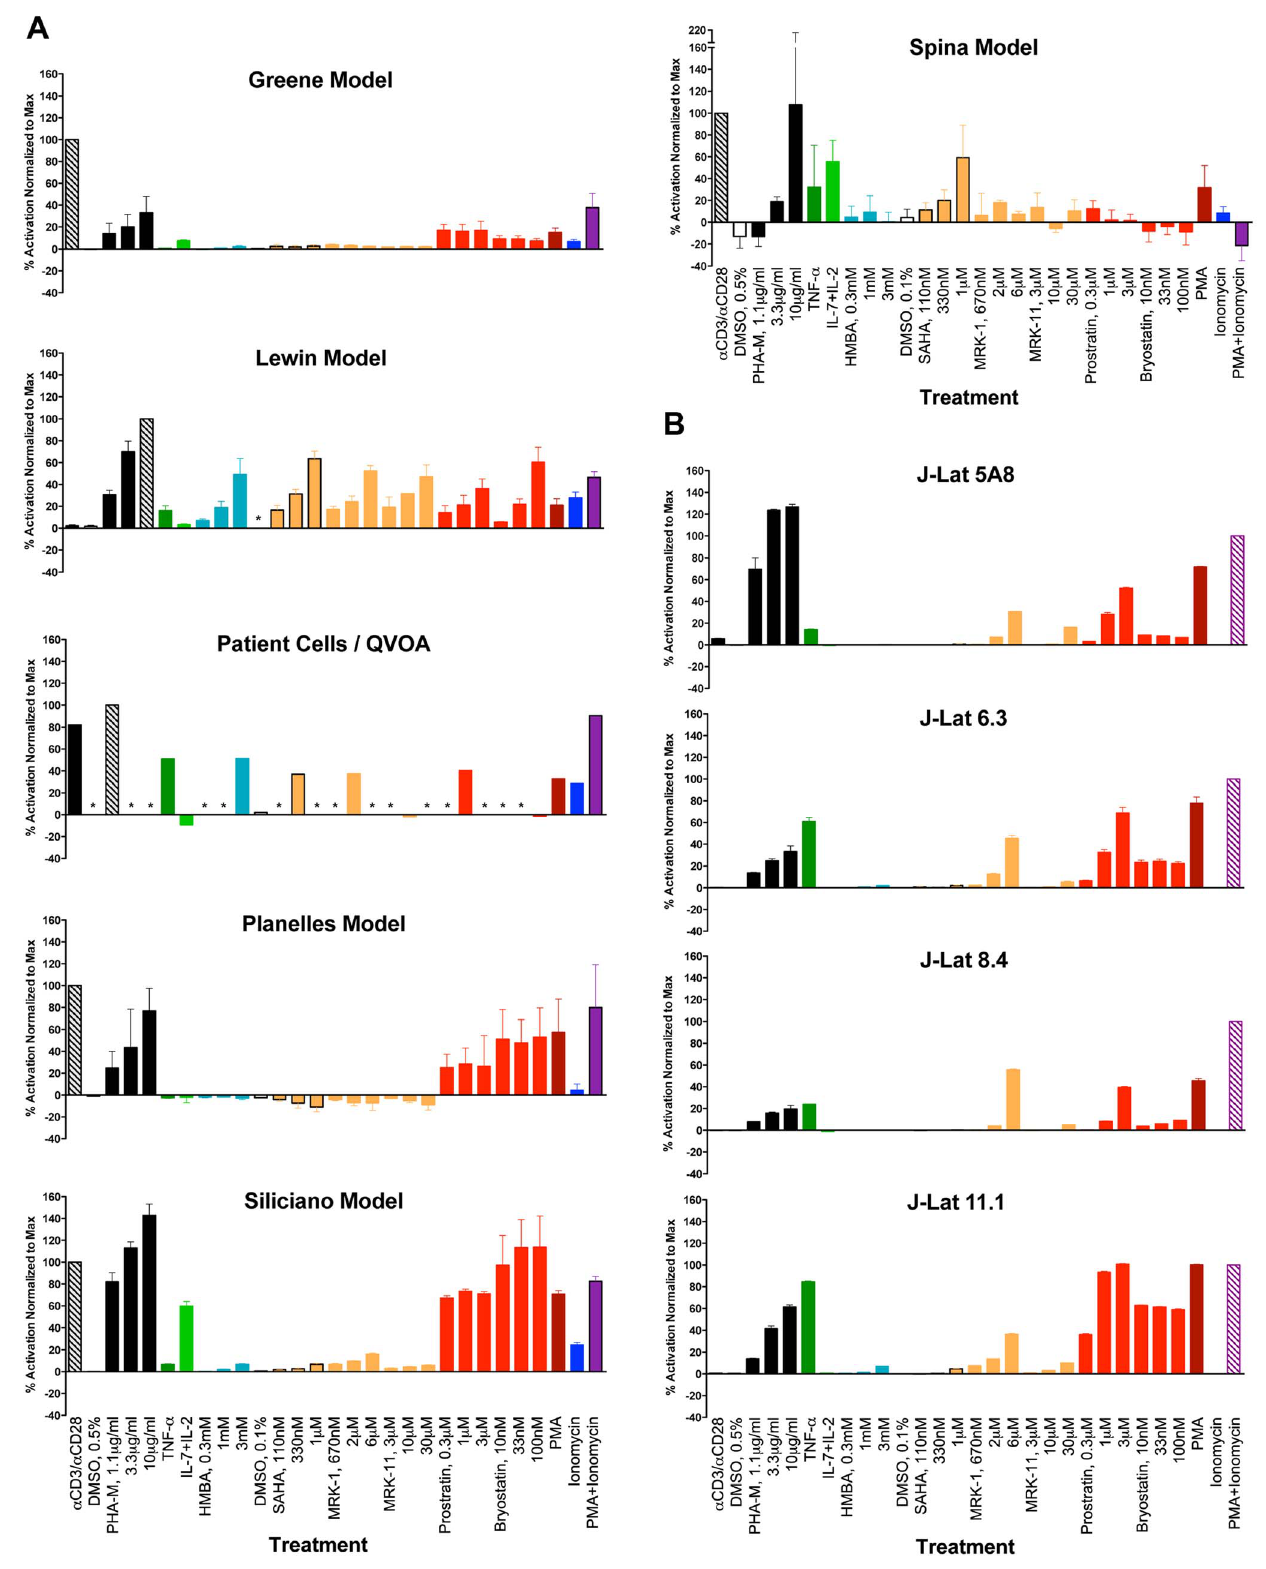
Figure 1. Graphic summary of the ability of each compound to activate HIV within each cell model: (A) primary CD4 T cell models and patient cell outgrowth assay (QVOA), and (B) J-Lat T cell line clones. Each compound and concentration tested is listed on the X-axis. In the primary CD4 cell models, each compound was tested using cells from 2, 3 or 4 different donors and in duplicate or triplicate with cells from each donor (See Methods Section for details). For the QVOA, results from the limiting dilution cultures from 3 patients were pooled to calculate one